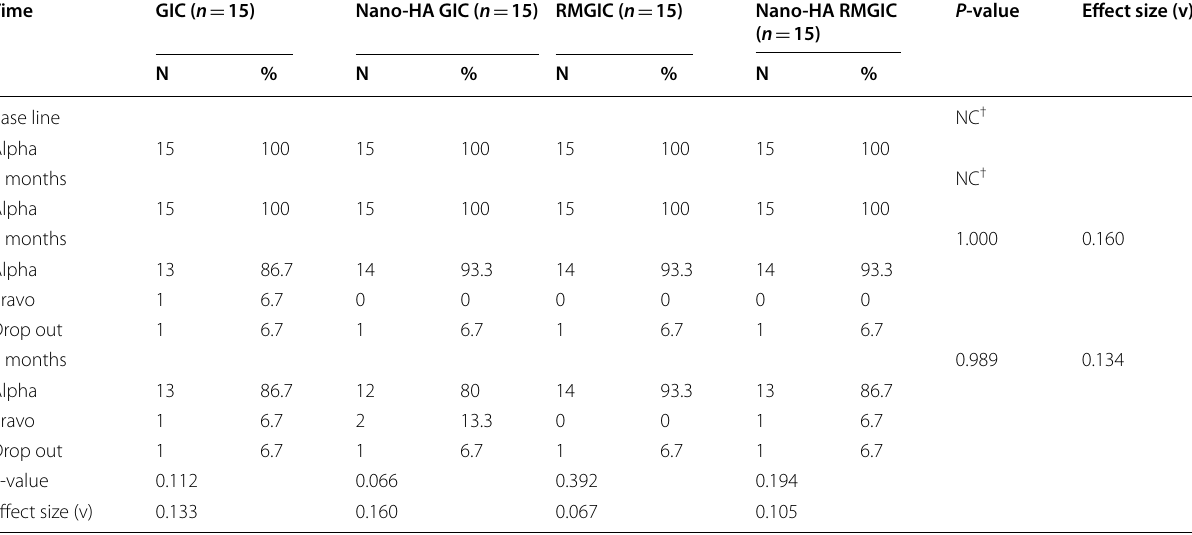
*Significant at P